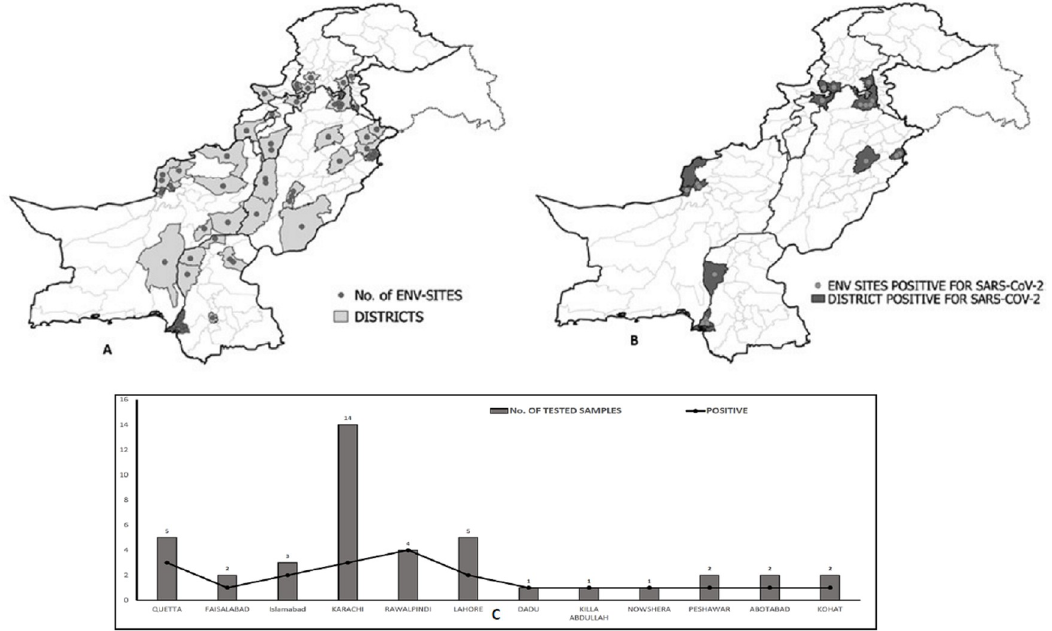
Fig 1. Geographical representation. A. Map indicating environmental sampling sites. Each dot represents a wastewater collection site B. Map representing districts with SARs-CoV-2 positive wastewater samples as dark grey color. Each dot represents a positive wastewater sample C. Graphical representation of positive samples among tested